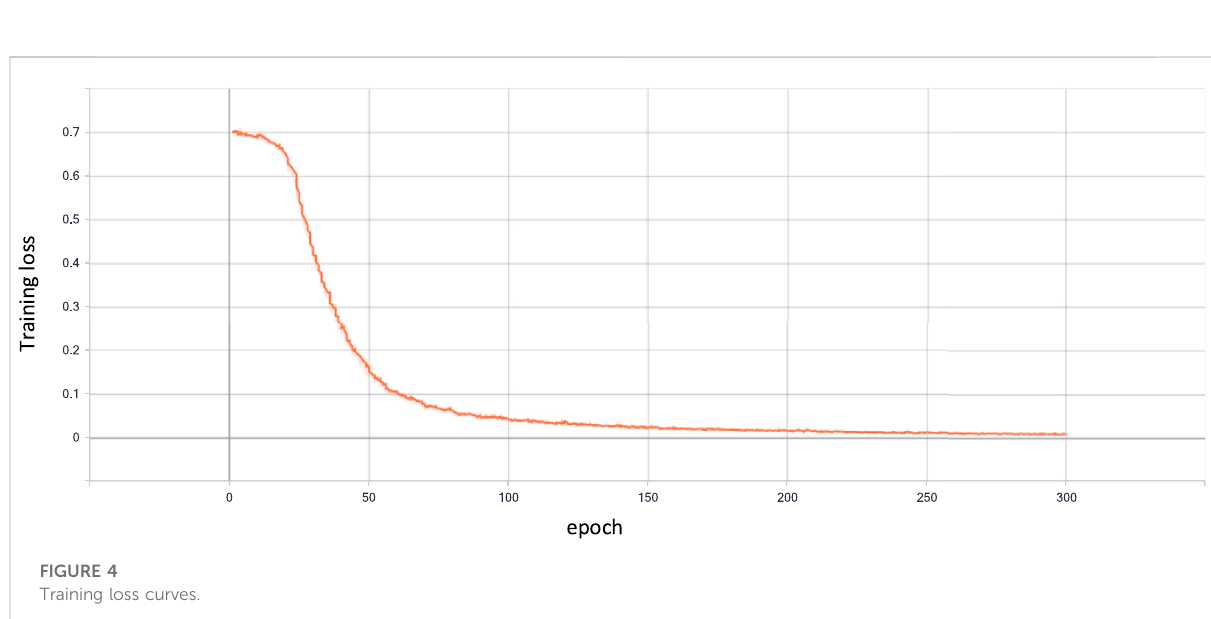
FIGURE 4 Training loss